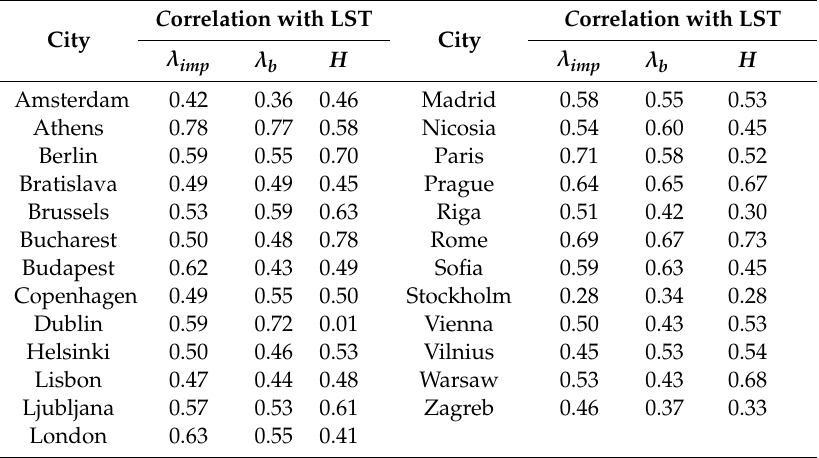
Table 5. As in Table 4, for observations during nighttime.